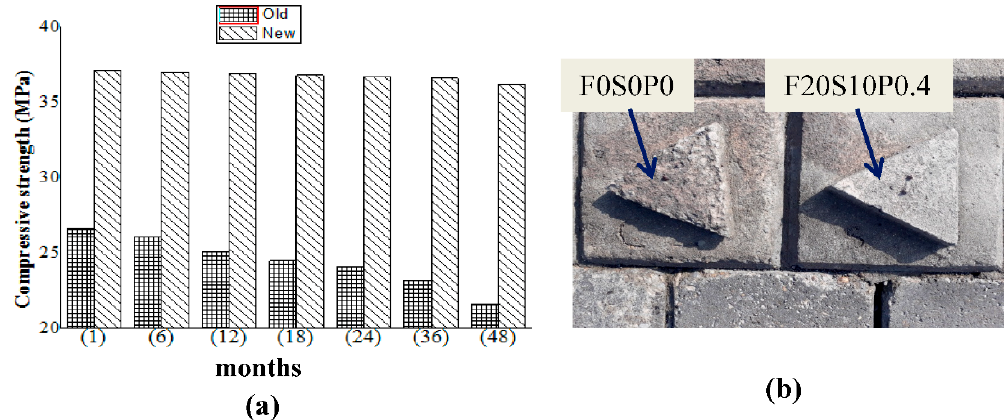
Figure 8. Field test: ( a ) average compressive strength in the field experiment and ( b ) the surface of the components after use for 4 years.